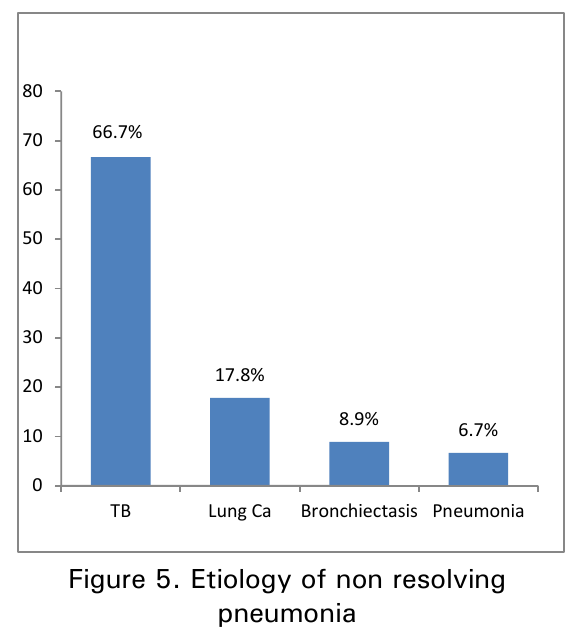
Figure 5. Etiology of non resolving pneumonia Tuberculosis was the commonest cause of non resolution of